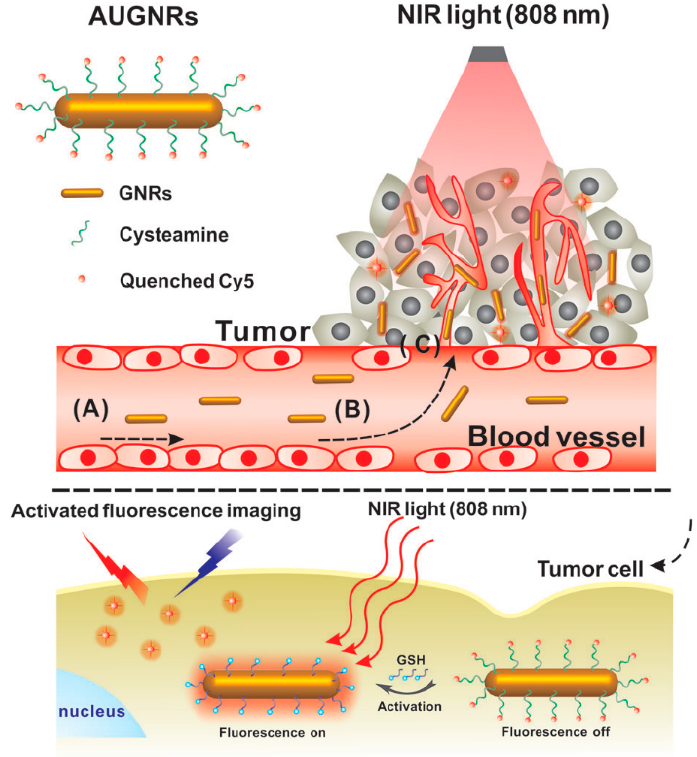
Figure 10. Schematic illustration of the whole procedure for the activatable ultrasmall GNR-based “off–on” fluorescence imaging-guided PTT in tumor cells [28].